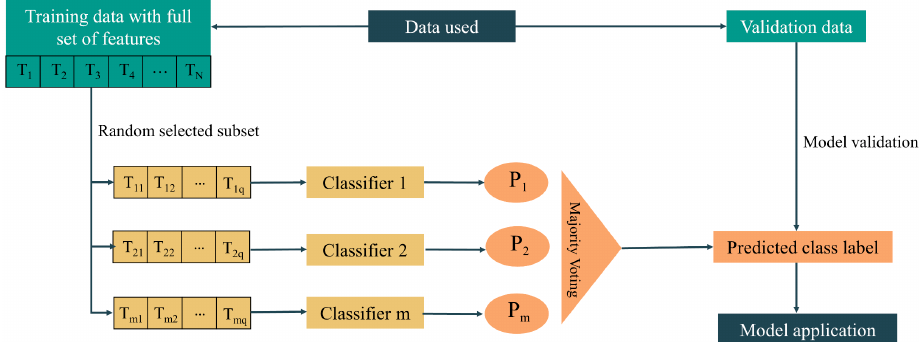
Figure 6. Random subspace learning process: training and validating.